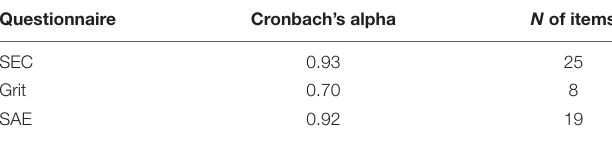
TABLE 2 | Questionnaires’ reliability.